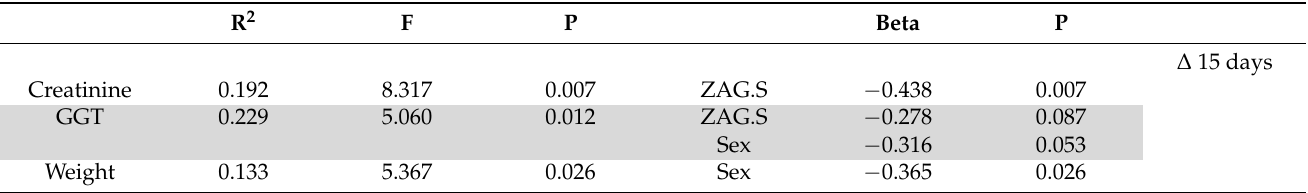
Table 4. Regression analysis predicting clinical and biochemical changes using sex and subcutaneous ZAG (ZAG.S) gene expression levels as independent variables.